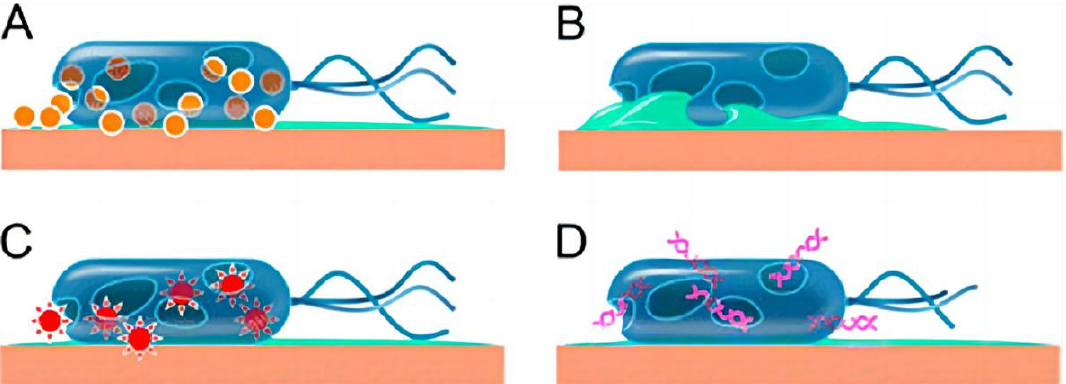
Figure 4. Diagrammatic sketch of contact killing. (A) Silver ions are released from the silver containing materials and cause cell damage. (B) The cell membrane ruptures because of silver and other stress phenomena, leading to loss of membrane potential and cytoplasmic content. (C) Silver ions induce the generation of reactive oxygen species, which cause further cell damage. (D) Genomic and plasmid DNA becomes degraded. Reprinted with permission from ref [58] 2011, Appl. Environ. Microbiol.